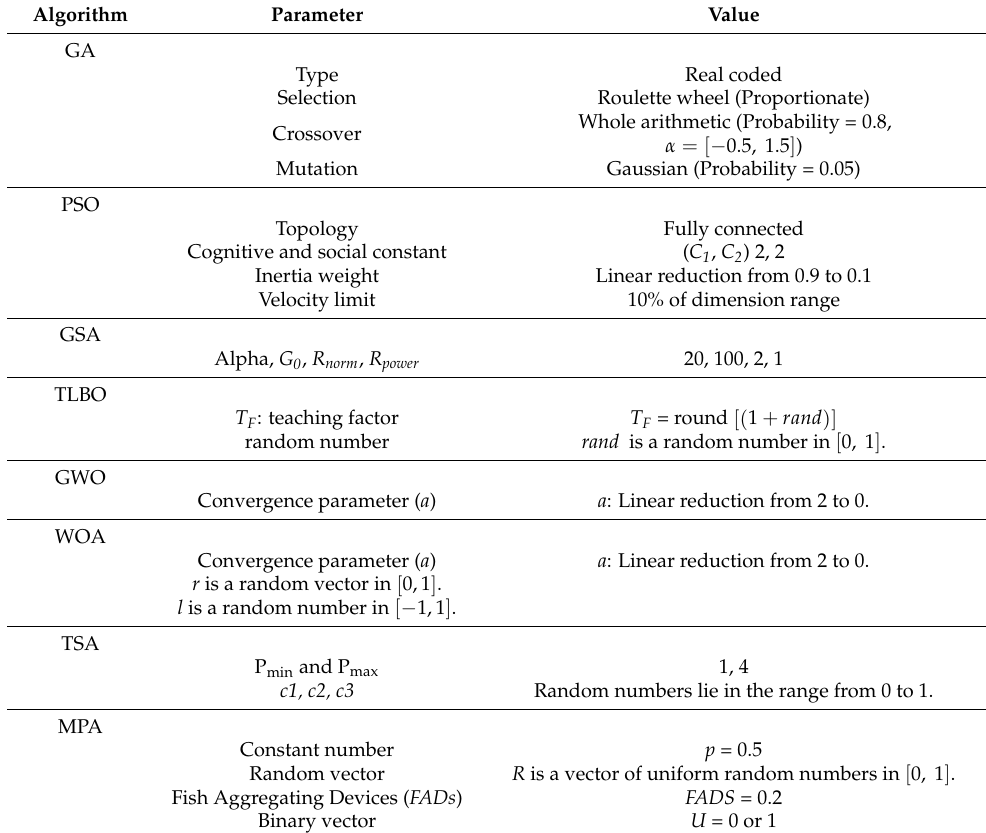
Table 1. Parameter values for the comparative